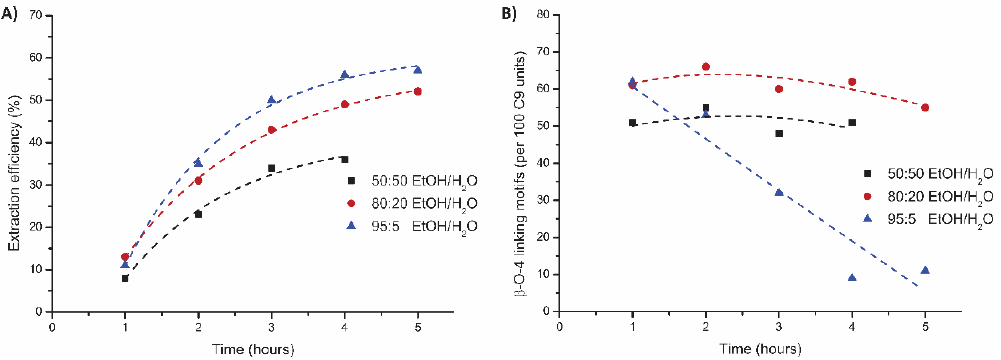
Figure 4. Influence of the different H 2 SO 4 concentrations on the mild organosolv extraction * (80:20 EtOH/H 2 O, 120 °C, 5 h) on ( A ) extraction efficiency (corrected for alcohol incorporation as determined by 2D HSQC) and ( B ) total β-O-4 content as determined by 2D HSQC. * Different walnut source than starting point experiment.